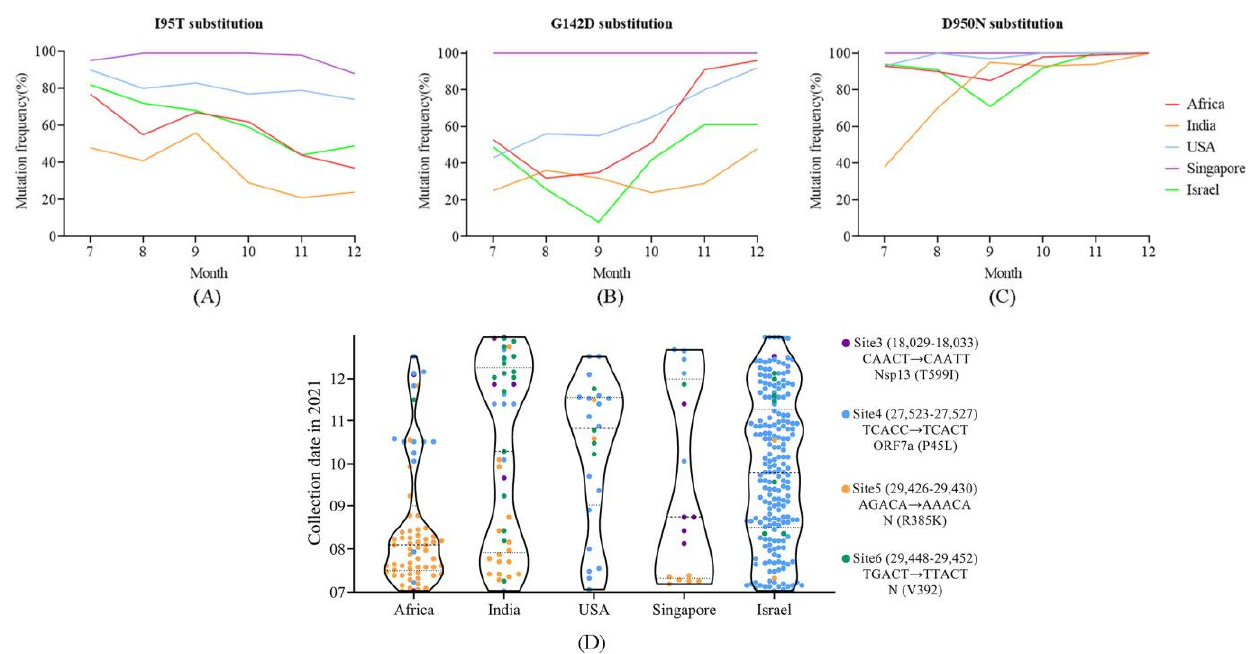
Figure 5. Specific mutation site analysis. ( A – C ) Temporal distribution of the three important amino acid sites in the S protein under strong positive selection in different countries/regions. The occurring frequencies of G142D and D950N increased over time. ( D ) Spatial-temporal distribution of the 361 sequences with mutations at m 6 A modification sites 3, 4, 5 and 6; each dot stands for a sequence. Mutations at site 4 were mainly distributed in Israel across different time, while mutations at site 5 were detected at the early stage and mainly distributed in Africa. The annotations of different sites are shown on the right side of the figure.